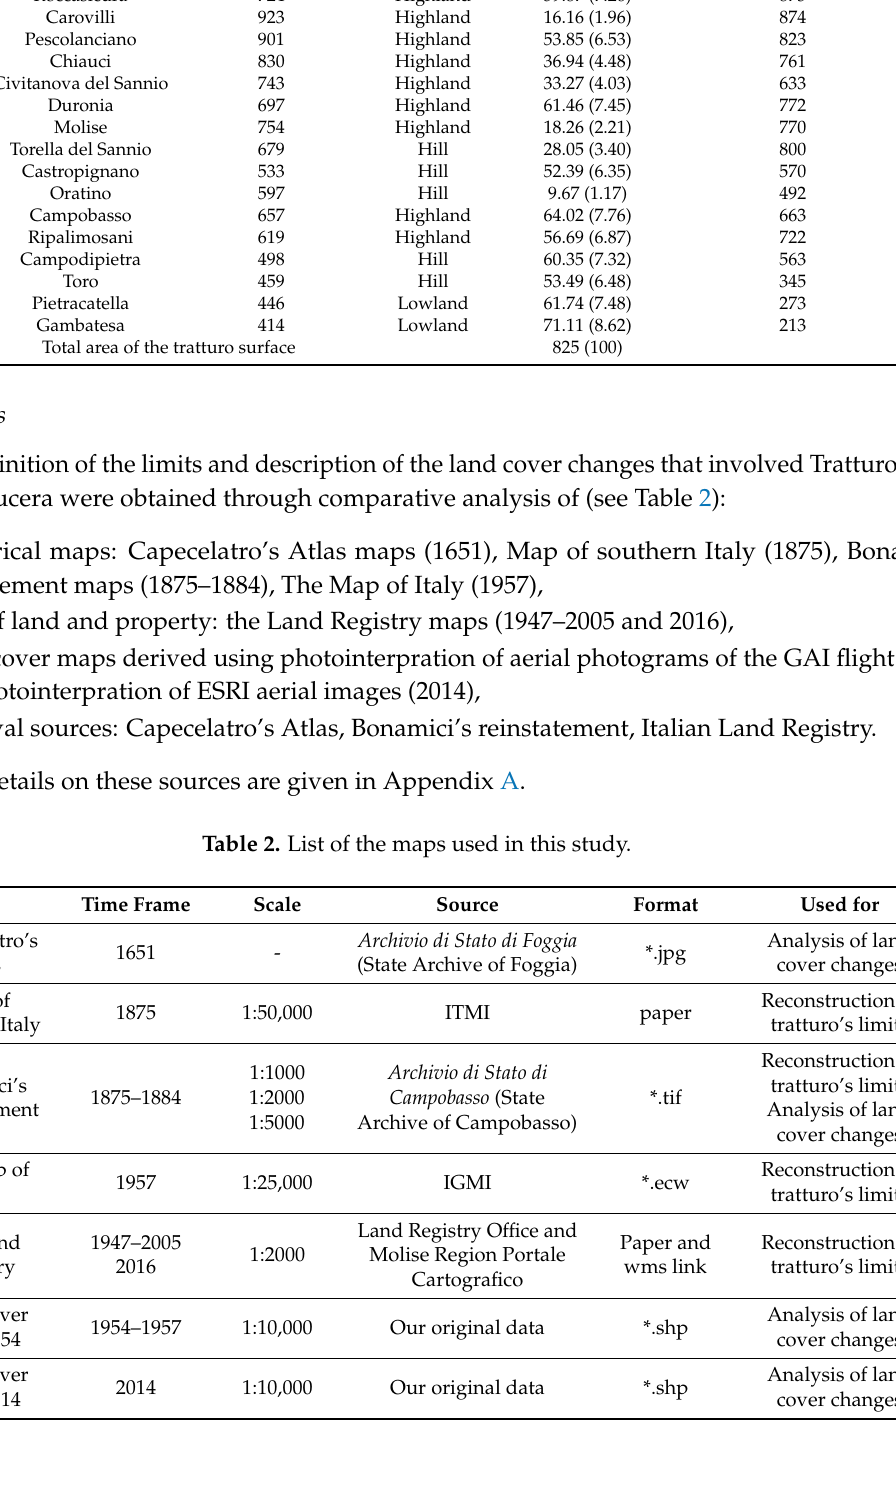
Average Altitude (m a.s.l.)